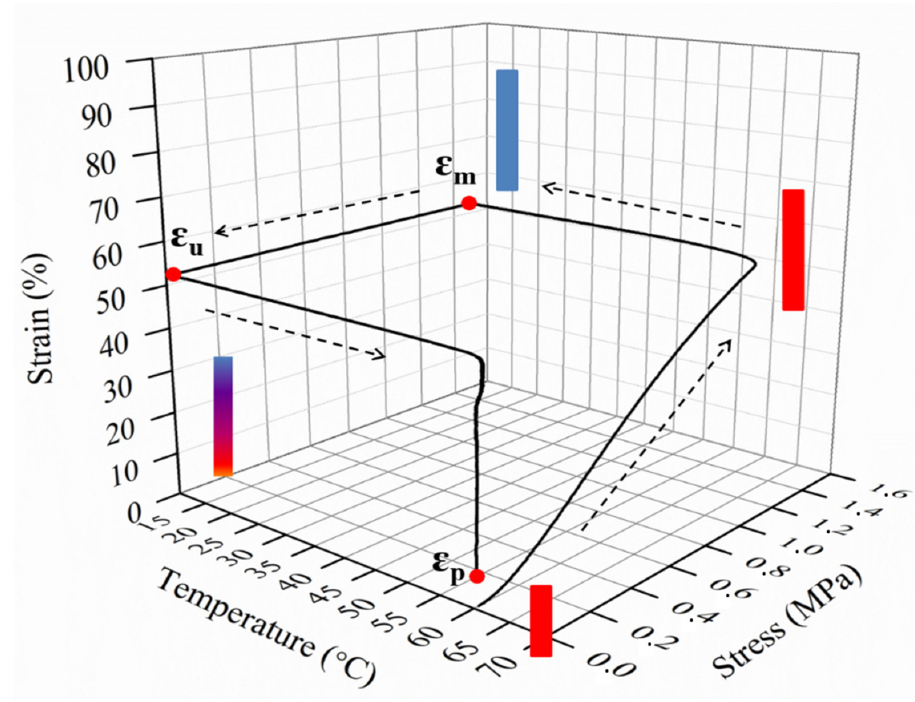
Figure 4. Schematic diagram of a 3D thermo-mechanical cycle and main parameters.